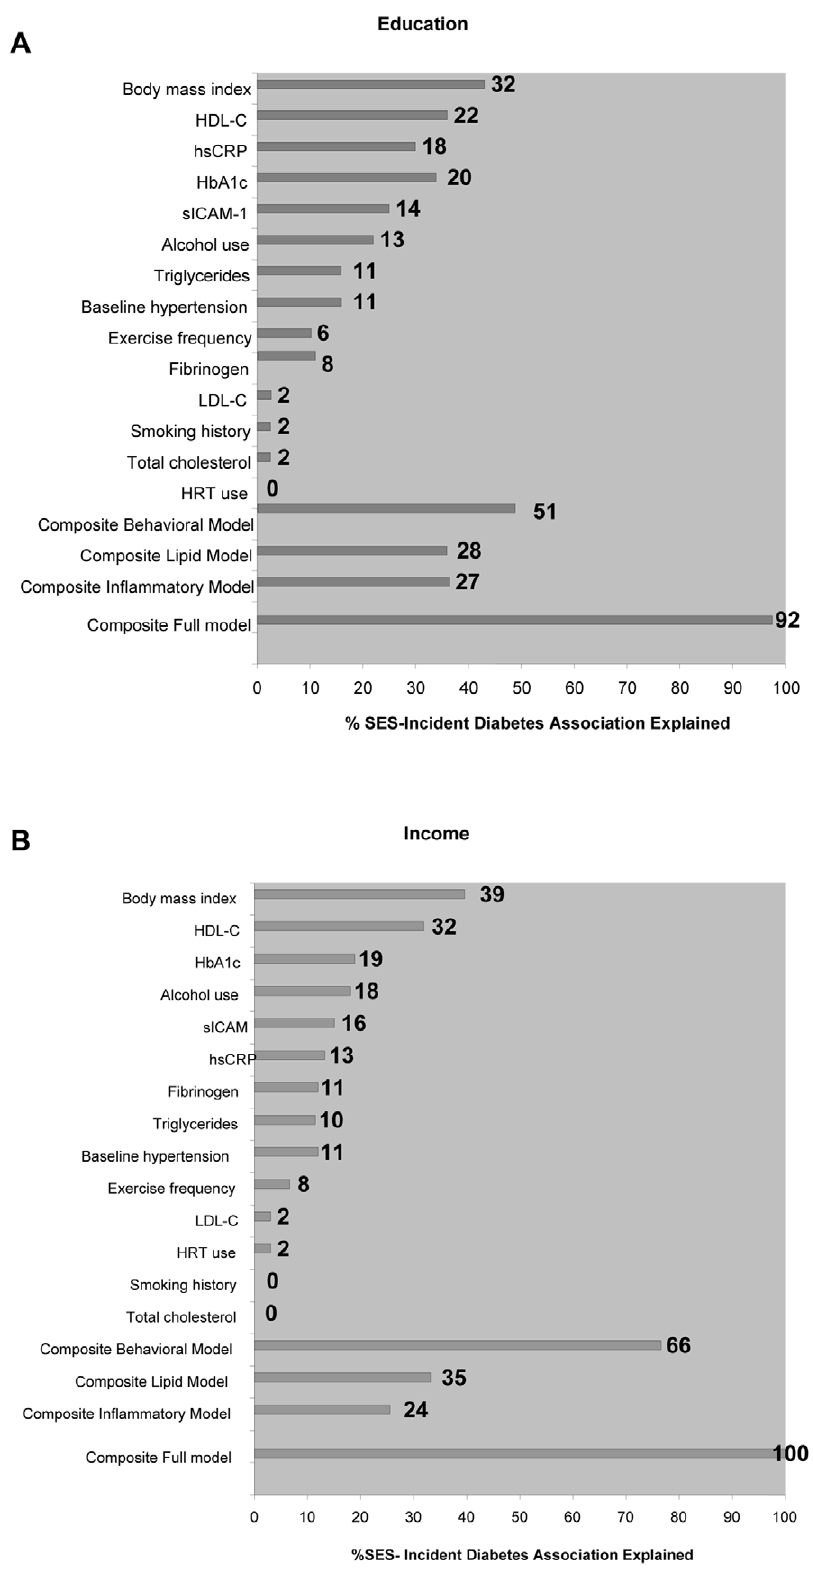
Figure 1. Percentage of socioeconomic status-incident diabetes association that is explained by mediators. The proportion of the risk attributable to increasing education levels; 1A) and for increasing income levels; 1B) that is explained by each mediator or set of mediators calculated as follows: (HR base model 2 HR adjusted model)/(HR base model 2 1) 6 100% [16–18]. HRs for the highest education or income categories compared with the HRs of the women with the lowest education or income without control for risk factors represented the base model whereas the adjusted model reflects control for each risk factor/risk factor category. Base model is adjusted for age, race/ethnicity and family history of diabetes. doi:10.1371/journal.pone.0027670.g001 PLoS ONE |